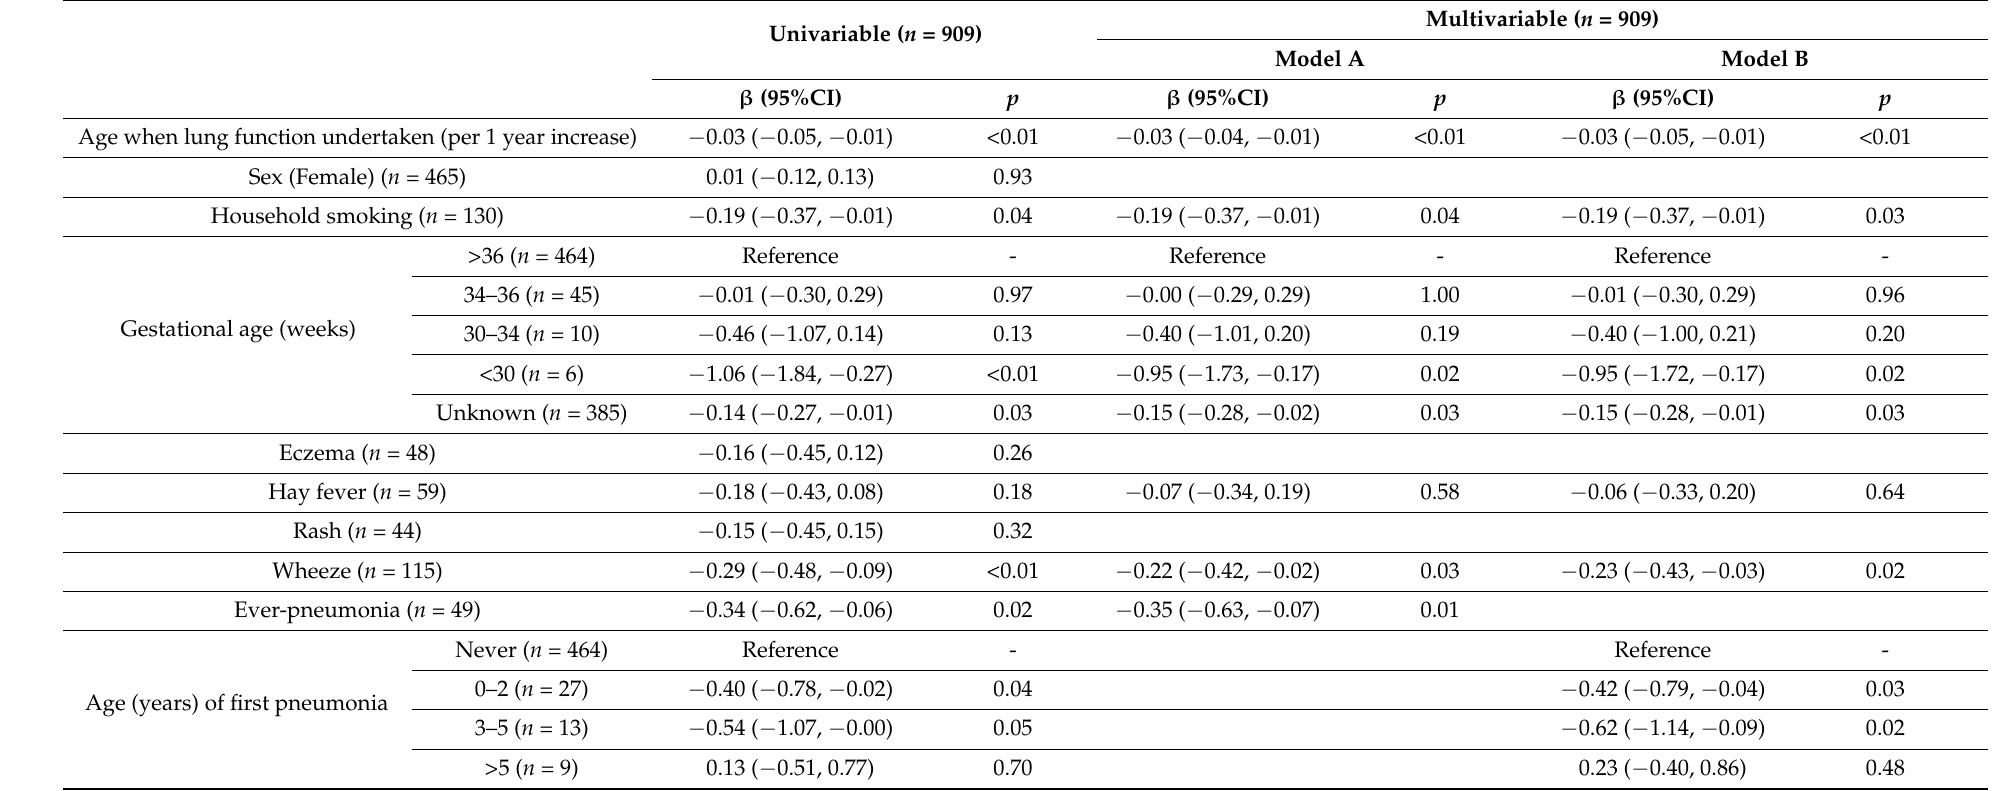
Table 2. Univariable and multivariable regression modelling of FEV 1 Z-scores in 909 First Nations